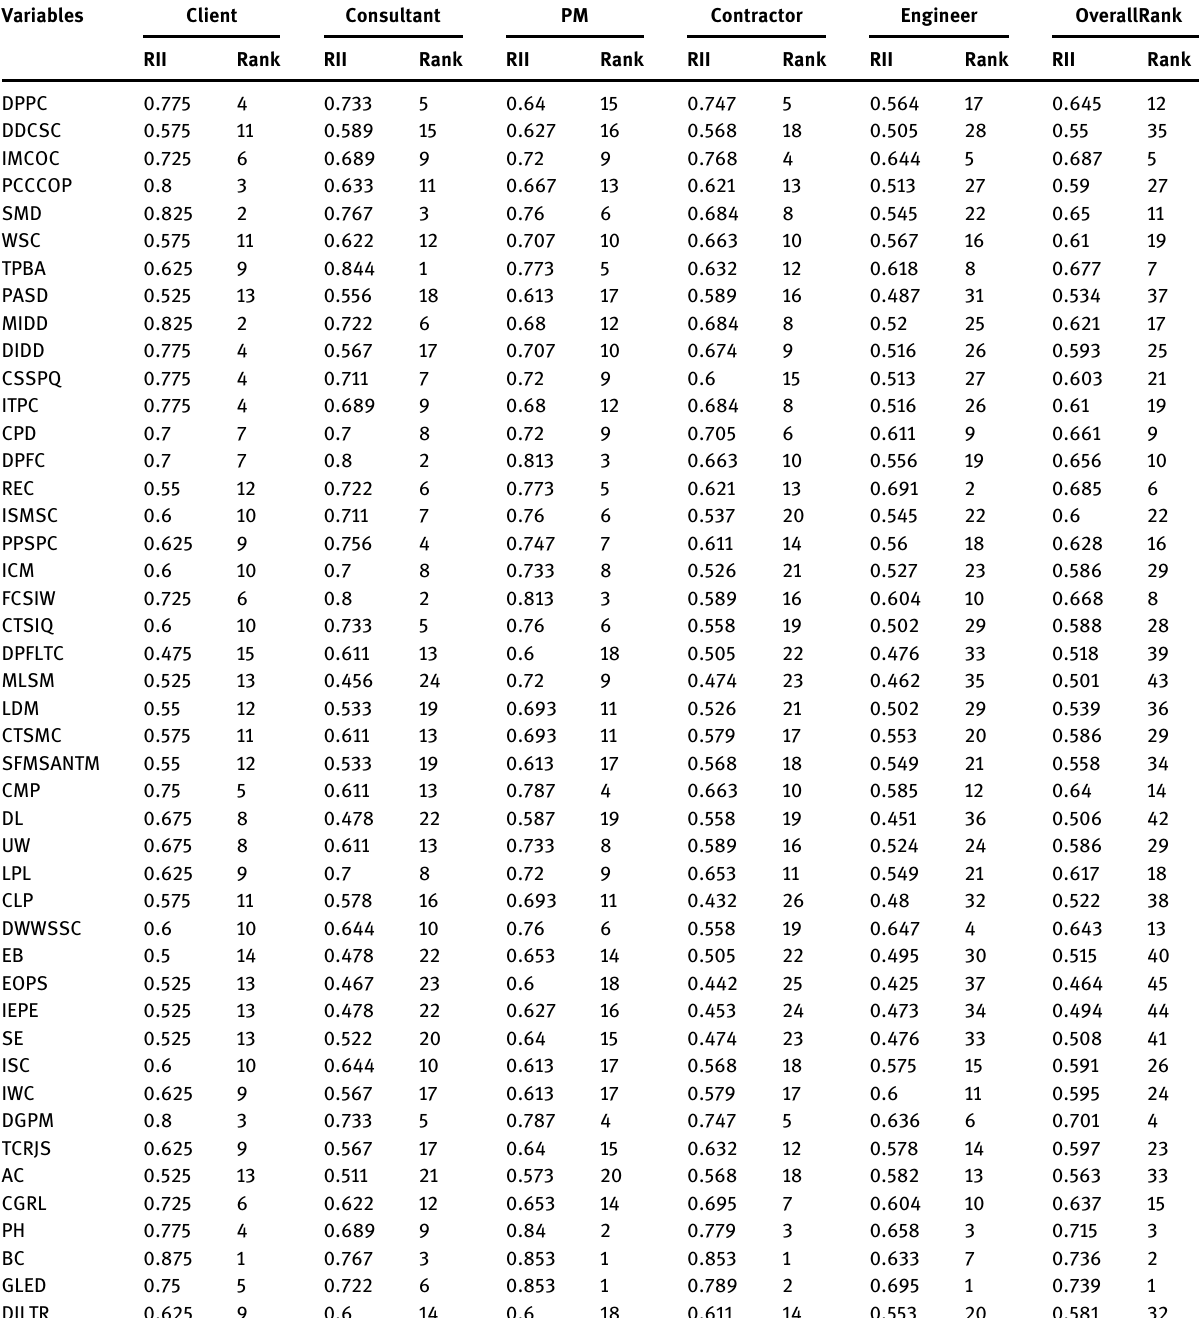
Table 4: RII and ranks of delay causes of construction projects